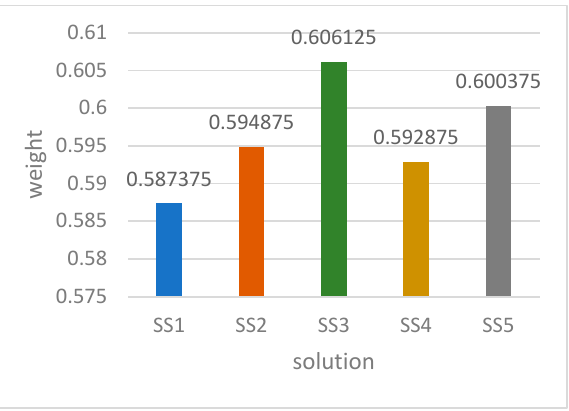
Figure 6. Calculated weights of the solutions at design of the inverting summing amplifier.